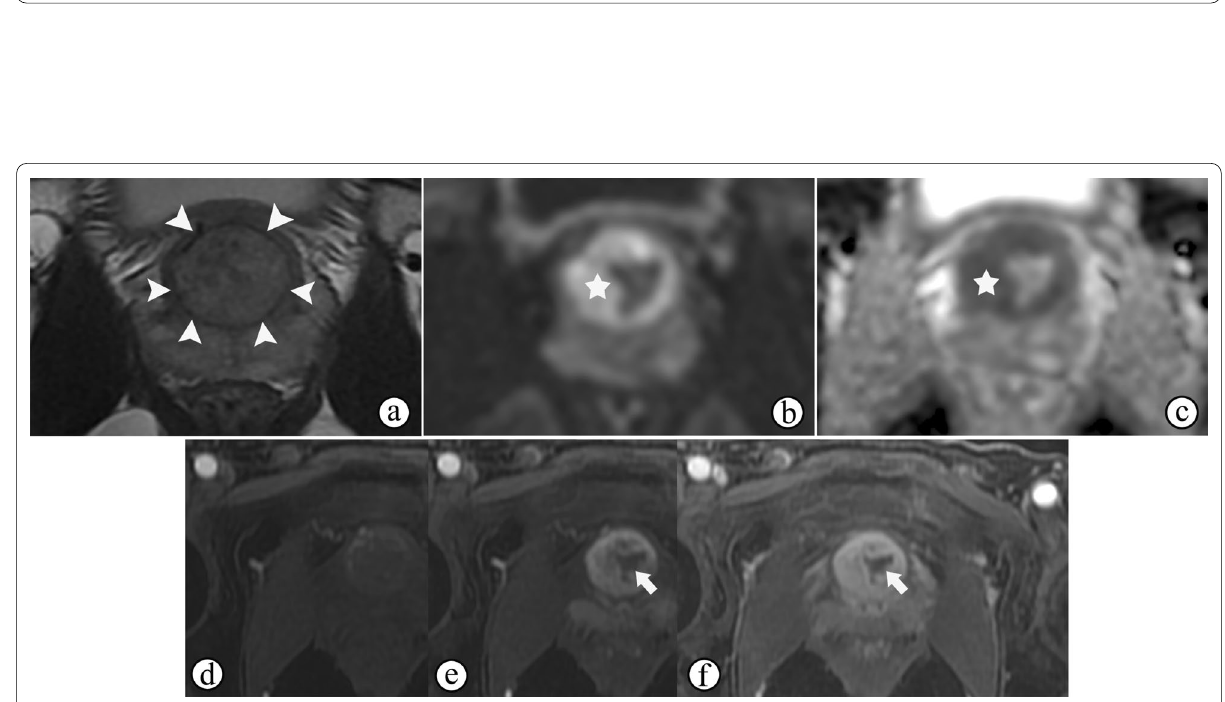
Fig. 12 Prostate stromal tumor of uncertain malignant potential in a 39-year-old man with a normal serum PSA level of 1.780 ng/mL. a Axial T2WI shows a well-circumscribed nodule with heterogeneous signal and an incomplete capsule (arrowheads) located in the left PZ of the prostate and compressing the extra-prostatic tissue. b DWI shows hypointensity, indicating no restricted diffusion of the nodule. c–f Axial DCE imaging at 30 s ( c ), 60 s ( d ), 120 s ( e ) and 180 s ( f ) after contrast injection shows the early and gradual enhancement of the nodule